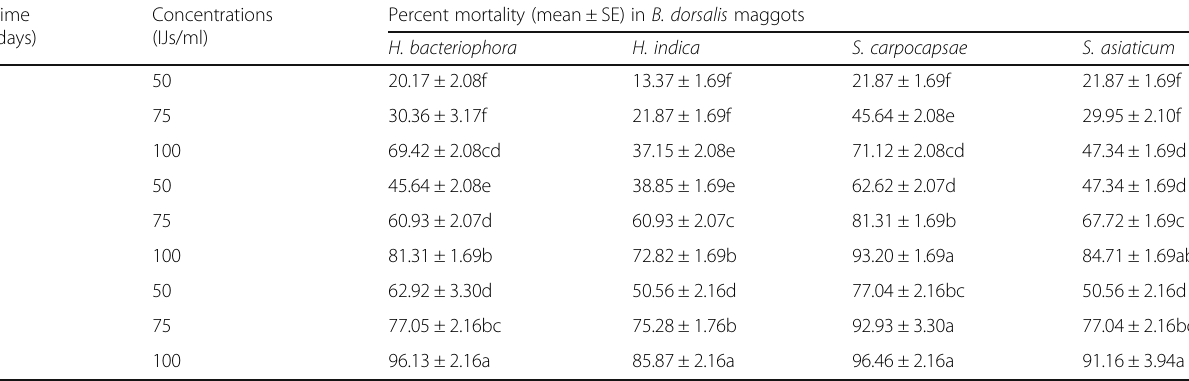
Table 1 Corrected percent mortality (mean ± SE) in Bactrocera dorsalis maggots (third instar) treated with Heterorhabditis bacteriophora , H. indica , Steinernema carpocapsae , and S. asiaticum at different concentrations and time period Time Concentrations Percent mortality (mean ± SE) in B. dorsalis (days) (IJs/ml)